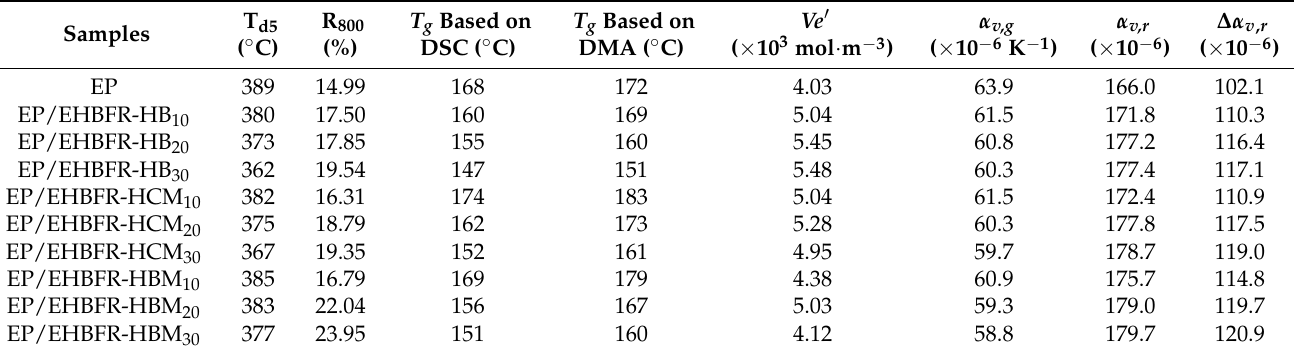
Table 3. T d5 , R 800 , T g , and physical parameters of epoxy